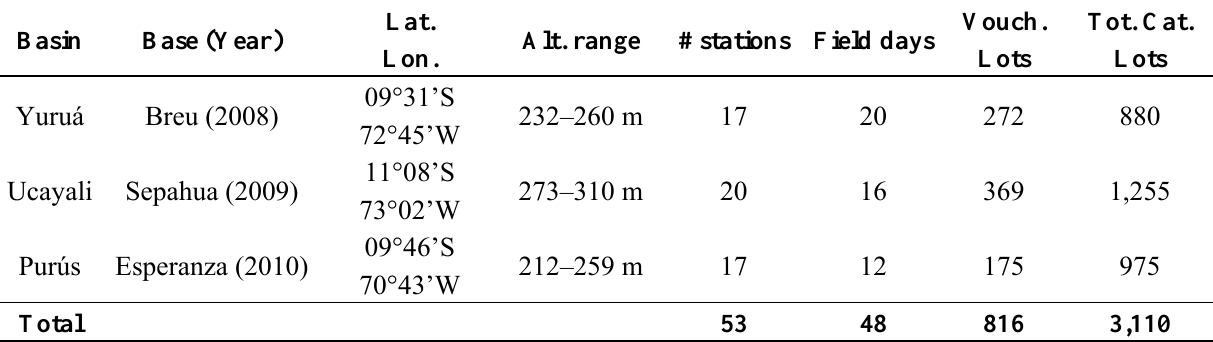
Table 3. Summary of locality data of collections to date in the Fitzcarrald region of Southeastern Peru under NSF-DEB 0741450. Vouchered lots = reference collection of morphospecies with digital images, tissue samples, and associated water quality data. Total cataloged lots at MUSM, Lima. Lat. Alt. Base (Year) Lon.